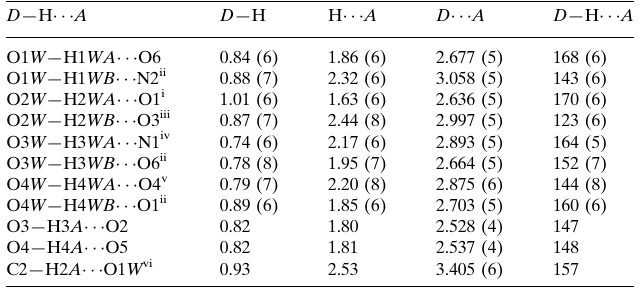
ligand Hydrogen-bond geometry (A˚ , (cid:2)